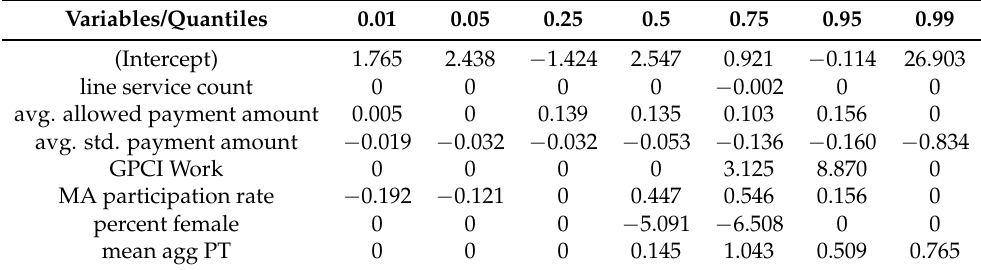
Table 4. MLE’s for chosen variables for LASSO Quantile Regression (Note: All the other variables are not selected, and hence have MLEs of